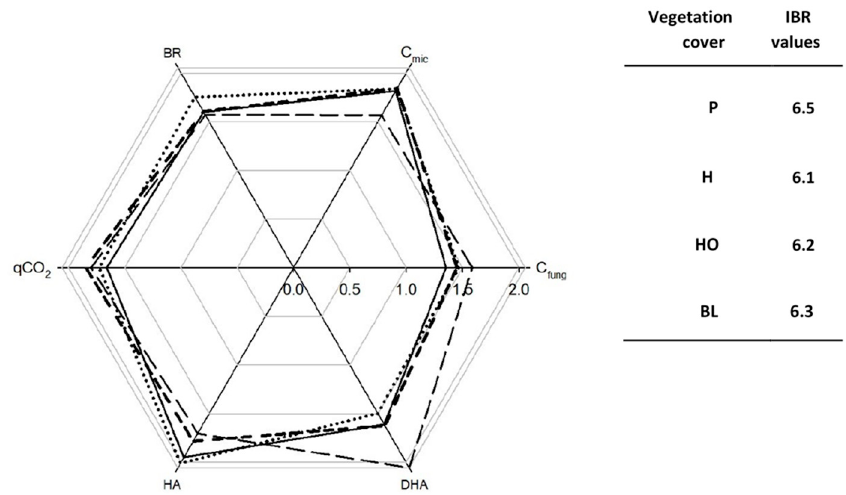
Figure 6. Biological response score star plot and Integrative Biological Response (IBR) of soils collected after the fire under herb (long dashed line), pine (medium dashed line), black locust (black line), and holm oak (dotted line) species.